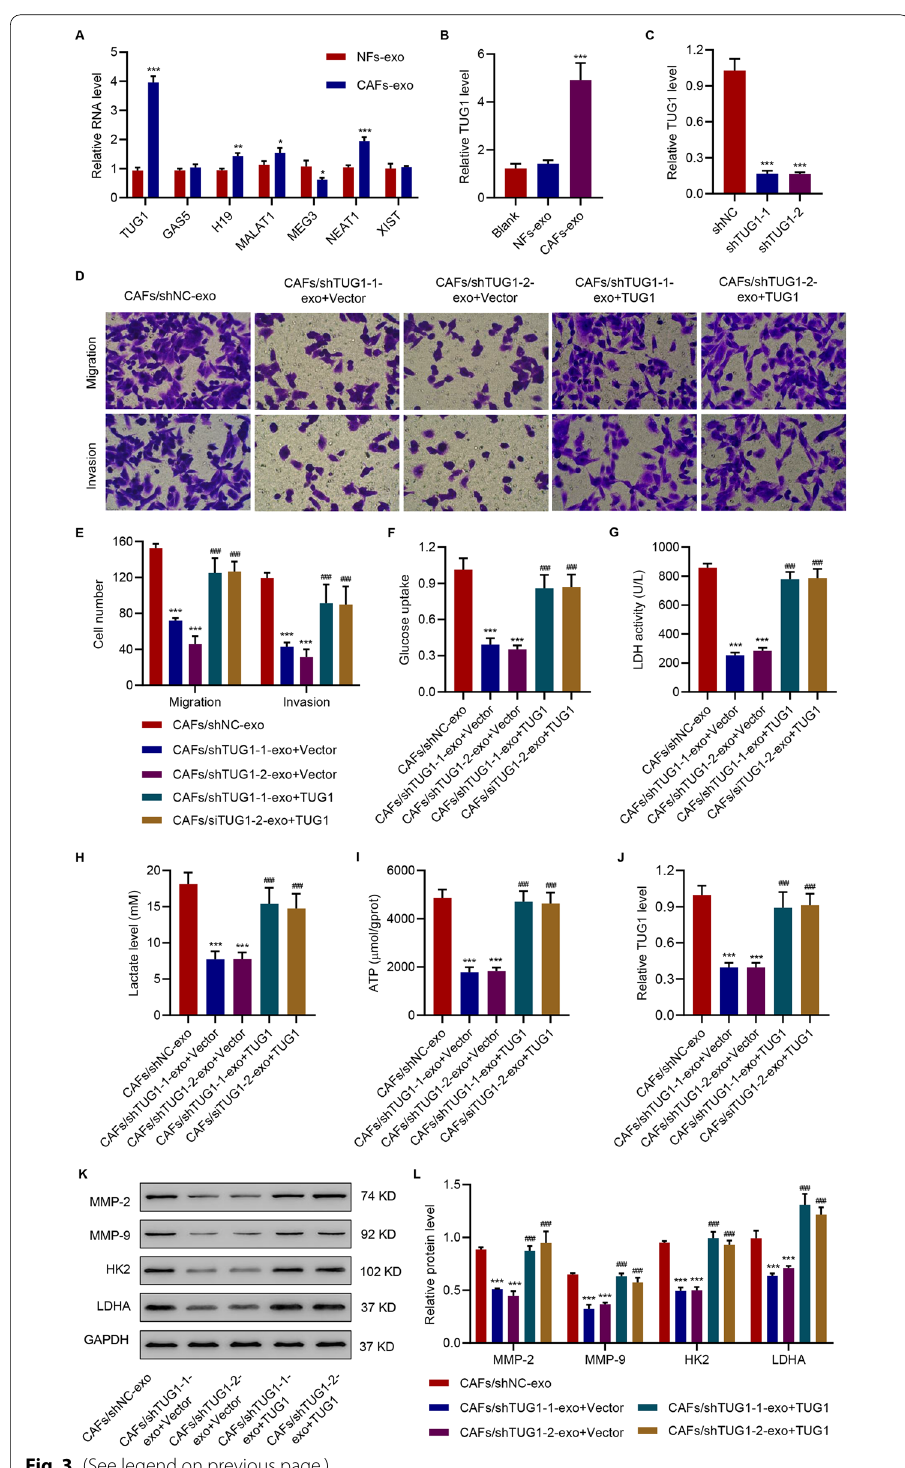
Fig. 3 (See legend on previous